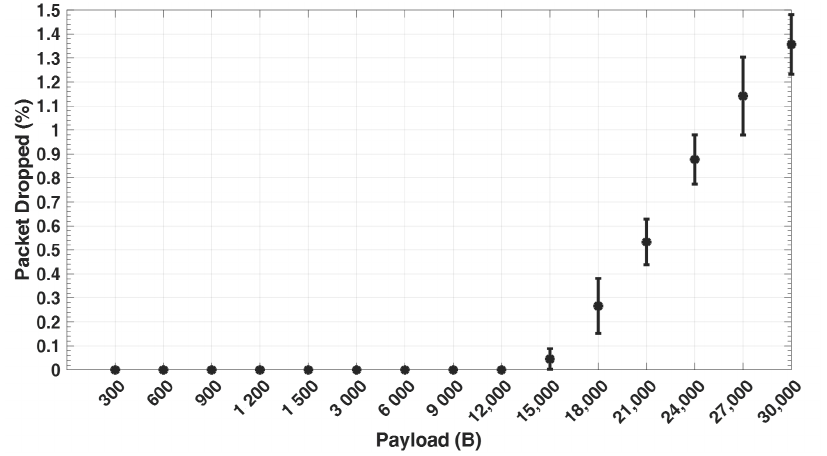
Figure 8. Packet loss due to retransmission